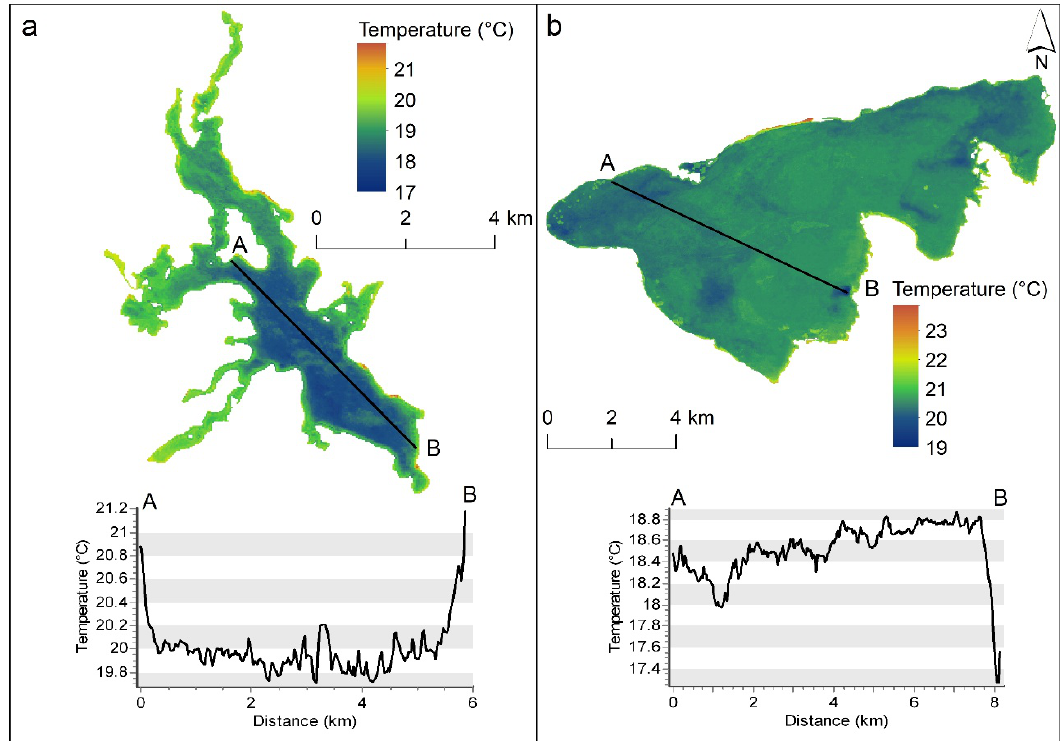
Figure 11. The surface temperature of ( a ) Drawsko Lake on 28 May 2018; ( b ) Łebsko Lake on 18 August 2015. The black lines labeled AB show a temperature profile from north-west (A) to south-east (B).